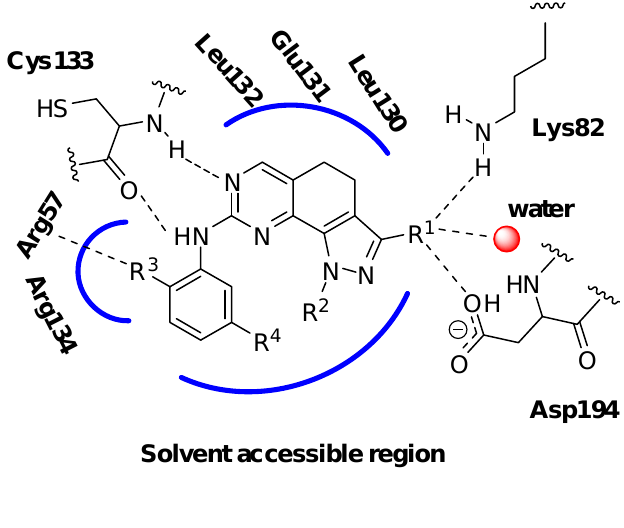
Figure 9. Schematic representation for the SAR of 4,5-dihydro-1 H -pyrazolo[4,3- h ]quinazoline derivatives as PLK1 inhibitors. R 1 : medium-sized substituent with hydrogen bond donor and acceptor; R 2 : open-chain alkyl group with less than three carbon atoms or unsubstituted hydrogen; R 3 : hydrophobic group with small size and strong electron-withdrawing atom, especially hydrogen bond acceptor; R 4 : bulky substituents simultaneously with hydrophobic and hydrophilic